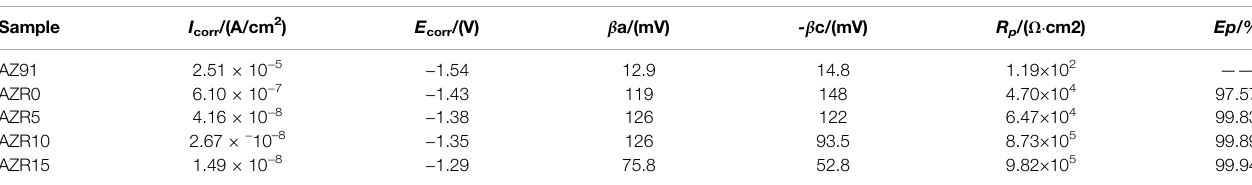
TABLE 3 | The parameters obtained from potentiodynamic polarization tests in 3.5wt% NaCl.